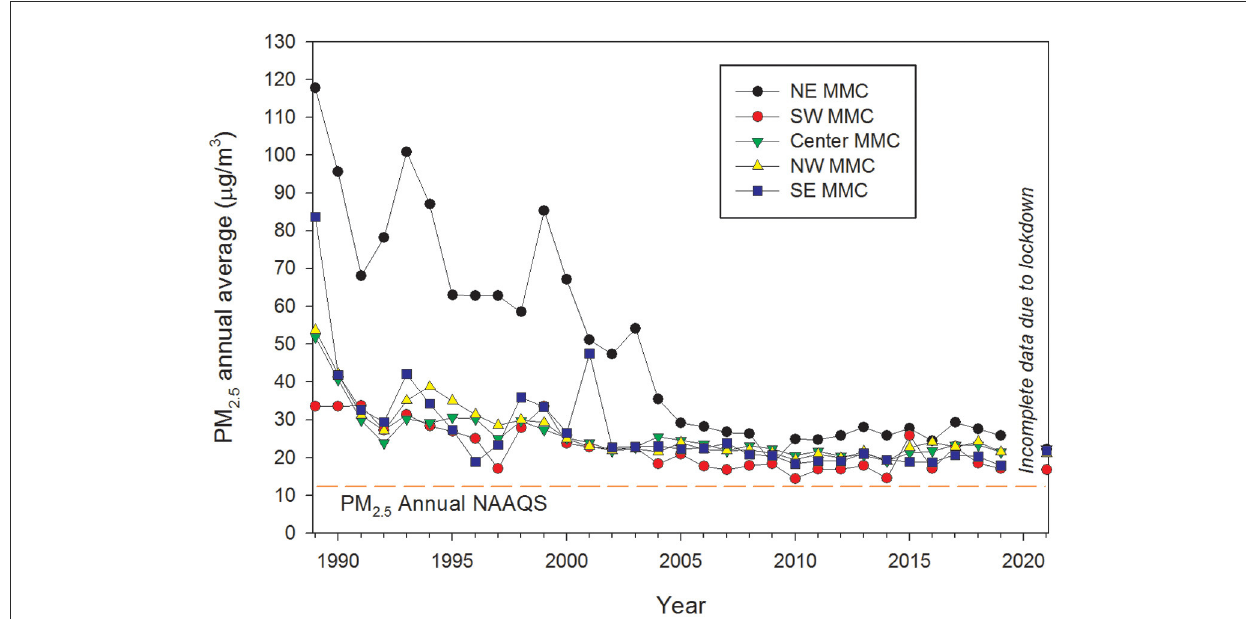
FIGURE1 Time series trend of annual mean 24-h PM 2.5 concentrations, averaged over 3 years, for five representative monitoring stations in MMC from 1990 to April 2020 and their comparison with the respective annual USEPA NAAQS. Data were processed and evaluated from measurements reported by the manual PM network of the Secretaría del Medio Ambiente del Gobierno de la Ciudad de México (SEDEMA) under a 6-day sampling schedule. Annual means from the years before 2004 were estimated from available information on PM 10 since 1990 and the mean slope of the correlation PM 10